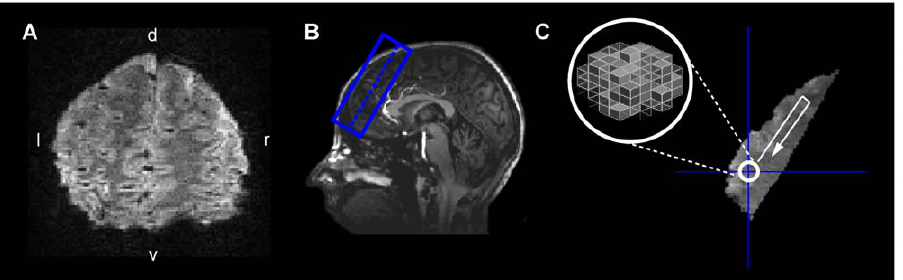
Figure 2. Illustration of EPI image, slice positioning and decoding approach. A) Example of one slice of one participant’s EPI image. B) Structural T1 image from the same subject displaying the positioning of the example slice (dotted line) and slice coverage (blue box). For each subject, 21–25 coronal slices (1 6 1 6 1 mm 3 , without gap) were positioned such that the most anterior part of frontopolar cortex was covered. Due to the optimized slice positioning, which allowed the use of a small field of view (FOV) and a short echo train length, a relative small part of the air-filled cavities was included. This improved the quality of the EPIs and reduced signal dropouts and distortions. C) The parameter estimates from the FIR model were used for multivariate pattern classification. A moving ‘‘searchlight’’ algorithm was implemented using a radius of 3 voxels in order to decode the outcome of the upcoming decision from each position in frontopolar cortex.